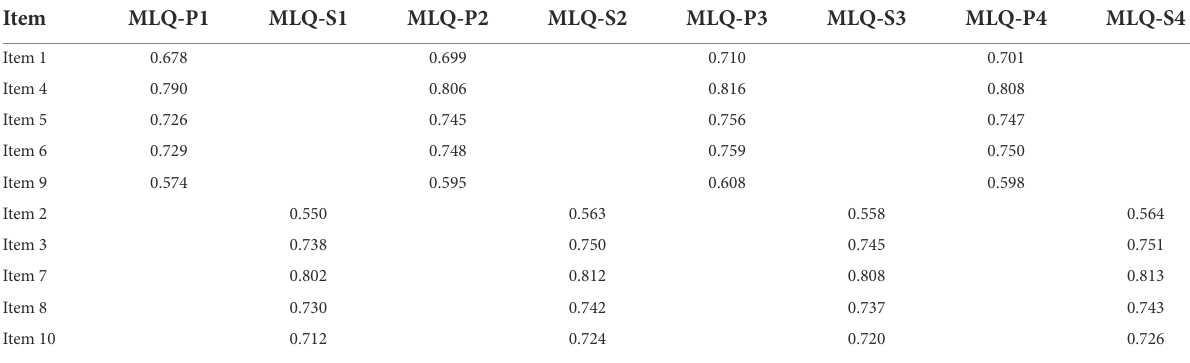
TABLE 4 Standardized factor loadings for the longitudinal factor model of the